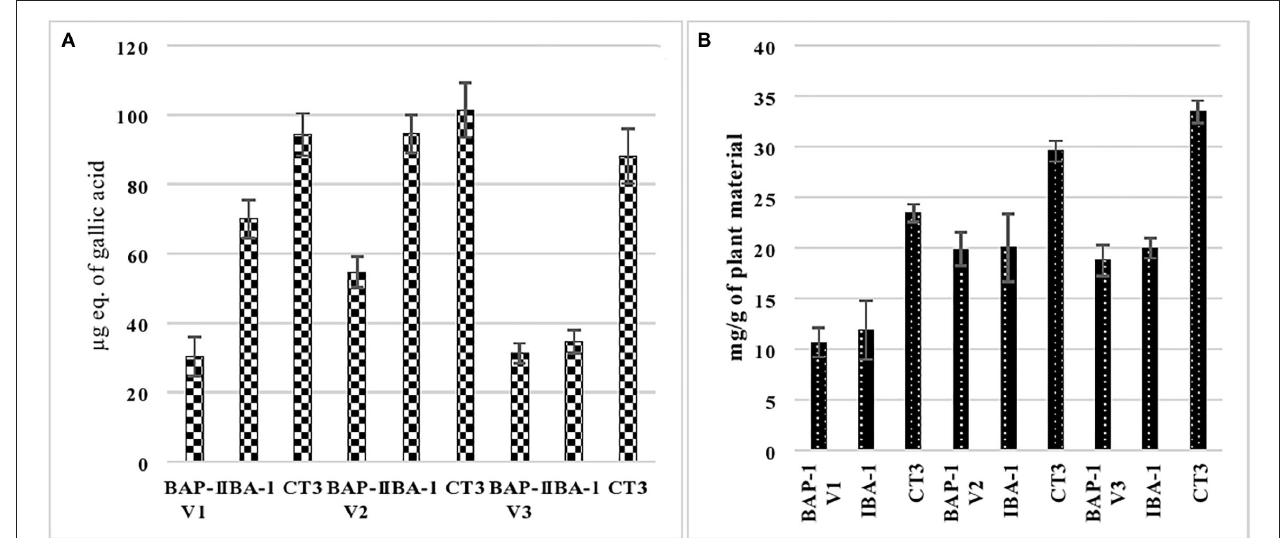
FIGURE 5 | Phenolic (A) and glycoside (B) analysis of selected cultures of three varieties of mung